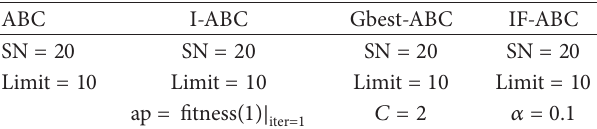
Table 1: Parameter settings for four ABCs.